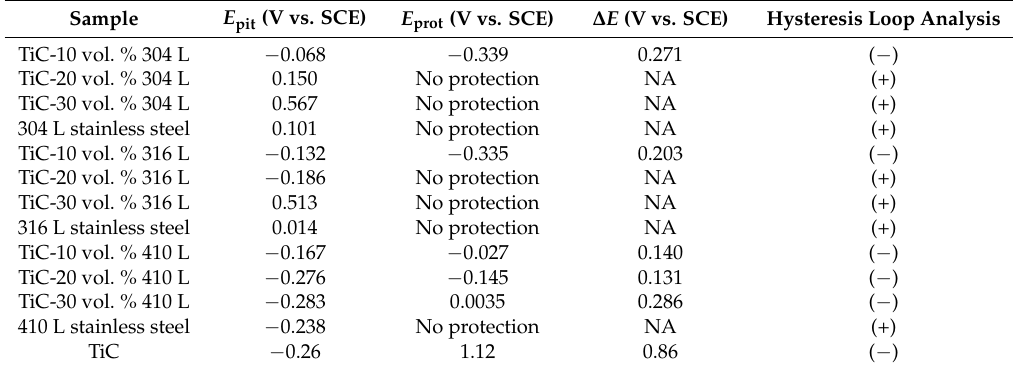
Table 5. Extrapolation of the pitting and protection potentials from the cyclic polarisation curves. Note that for the hysteresis loops, they are denoted by whether they are clockwise (+) or anti-clockwise ( − ).